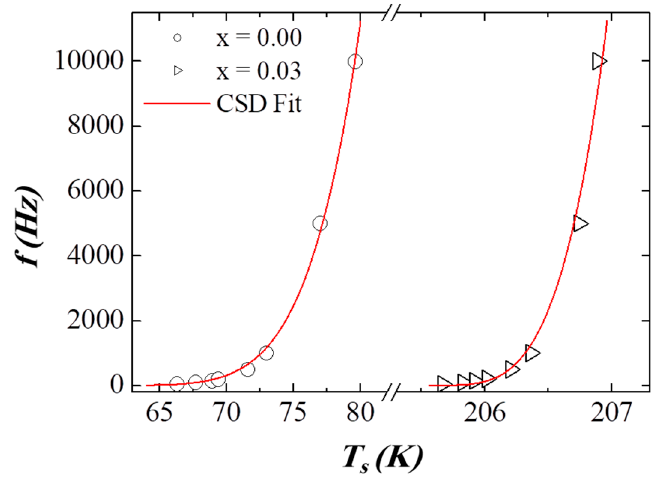
Figure 10. Plots of f versus T s for the two selected x = 0.00 and 0.03 NPs. The solid lines represent the critical slowing down (CSD) fit.